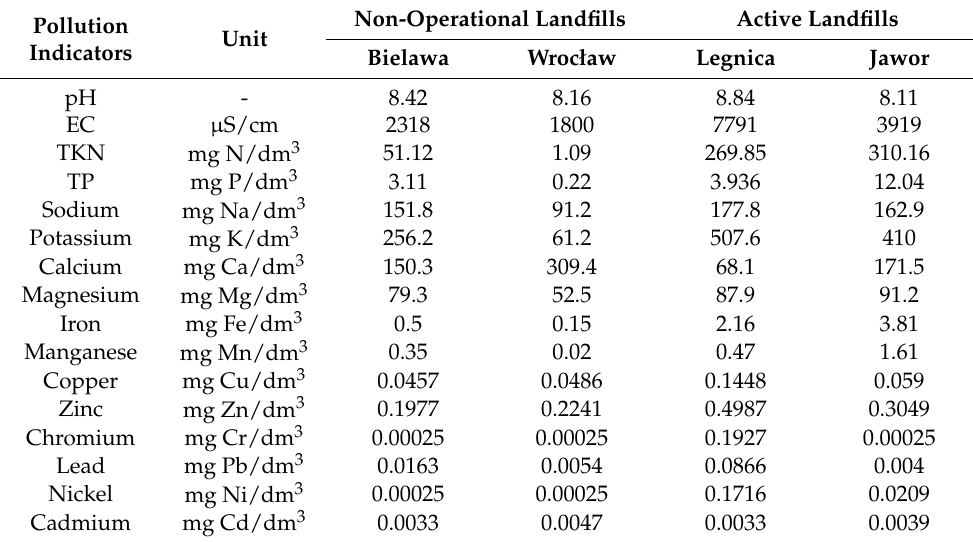
Table 1. Physicochemical characteristics of raw landfill